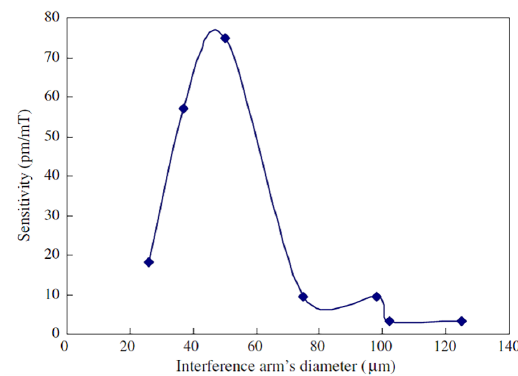
Figure 18. Correlation between the interference arm’s diameter and the magnetic field sensitivity.